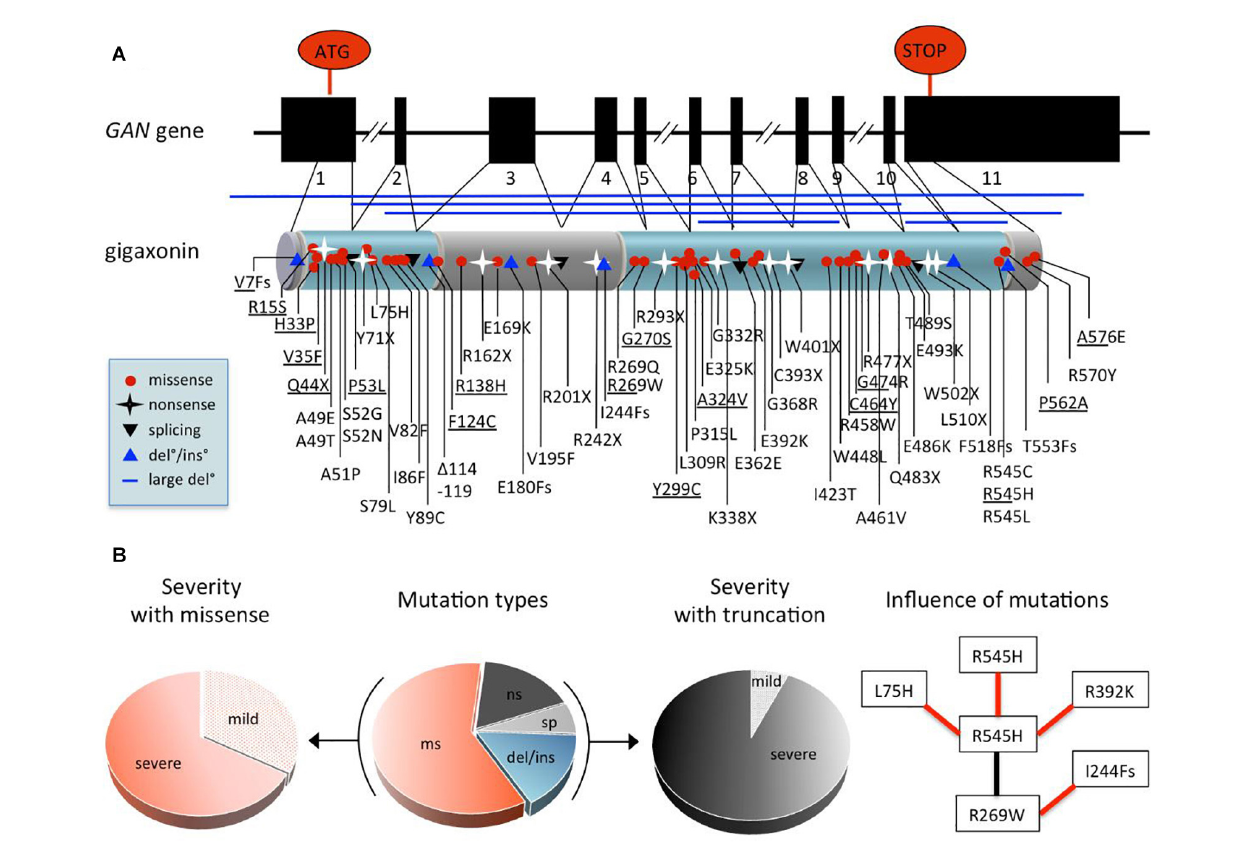
FIGURE 4 | Comprehensive analysis of GAN mutations. (A) Exon-intron structure of the GAN gene and domain organization of the encoded protein Gigaxonin, with a N-terminal BTB domain and a C-terminal Kelch domain (depicted in blue, linker is called BACK domain). Mapping of the 75 mutations (see also Supplementary Table 1 for details): missense mutation (red circle), nonsense mutations (black star), mutations at splicing sites (black triangle), deletions/insertion (blue triangle) and large deletion (blue line). (B) Pie charts depicting the effects of GAN mutations. Distribution of mutation types in patients (middle): 60% are missense mutations “ms,” 17.4% of nonsense mutations “ns,” 16% of deletions/insertions “del/ins,” and 6.6% mutations at donor/accepting splicing sites “sp.” Other pie charts indicate the predominance of severe forms associated with missense mutations (left) and truncations [(right), including “ns,” “sp,” “del/ins”], representing 67.7 and 93.3% of cases, respectively. On (right), flow chart showing the influence of mutations on severity. Black and red lines indicate, respectively that the patient bearing both mutations has a mild or severe form of the disease. As example, the R545H mutation leads to a severe phenotype when found homozygous, while it is attenuated by combination with R269W, which is severe when associated to